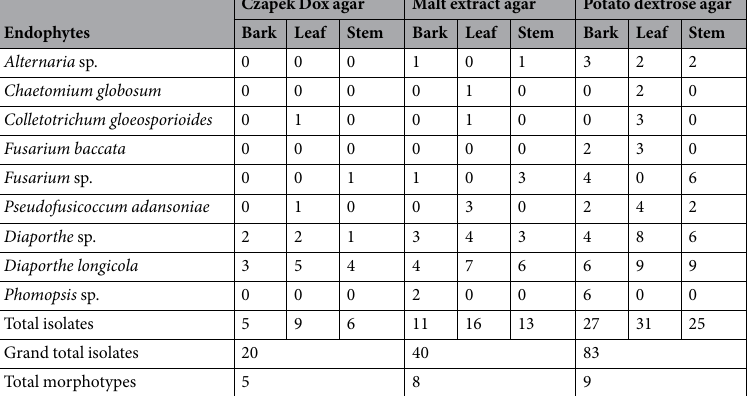
Table 6. Preliminary fungal endophytes isolation for suitable culture medium